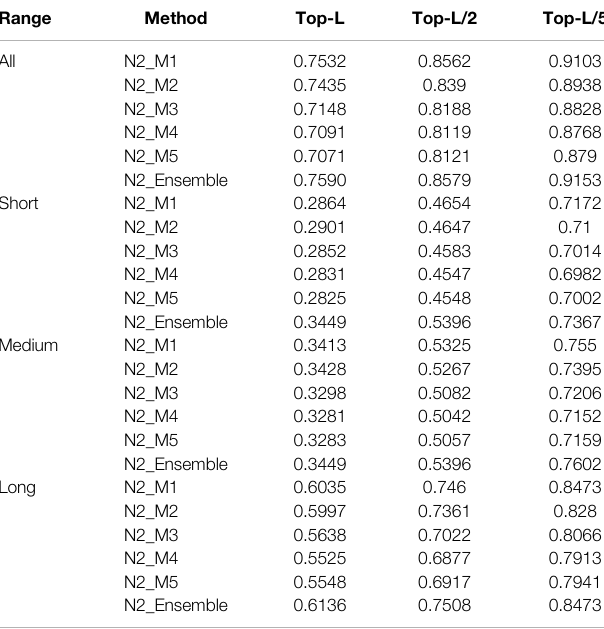
TABLE 3 | The prediction precisions of N2_M1/N2_M2/N2_M3/N2_M4/N2_M5/ N2_Ensemble for different sequence separations. -80 Range Method Top-L